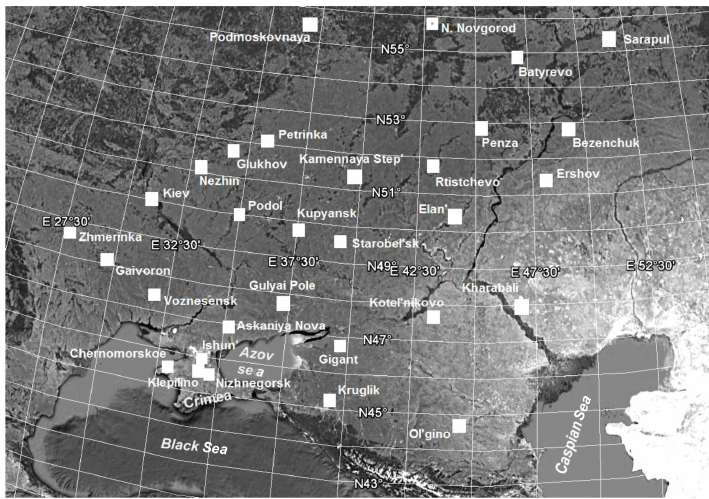
Figure 2. The study region (the southern part of the Russian Plain). The white squares are agrometeorological